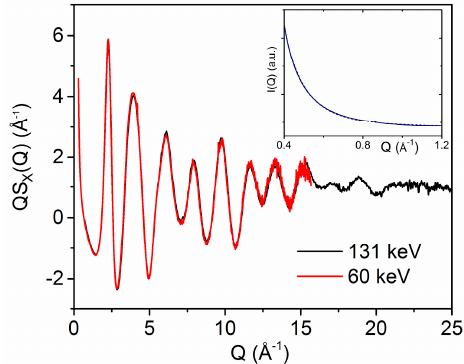
Figure 1. X-ray diffraction structure factors Q ∙ S X (Q) measured on the 2015 amorphous hafnia sample obtained using incident X-ray energies of 131 keV (black) and 60 keV (red). (Inset) Small angle scattering (Q = 0.4–1.2 Å − 1 ) measured at 60 keV (blue) and fit corresponding to the equation y = a + b ∙ Q − 3.94 (dashed line).